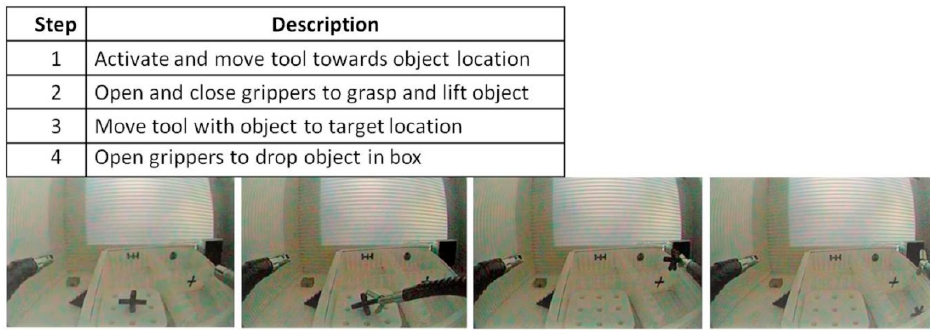
Figure 4. Description and visual illustration of the 4-step pick-and-drop task when performed with the right hand